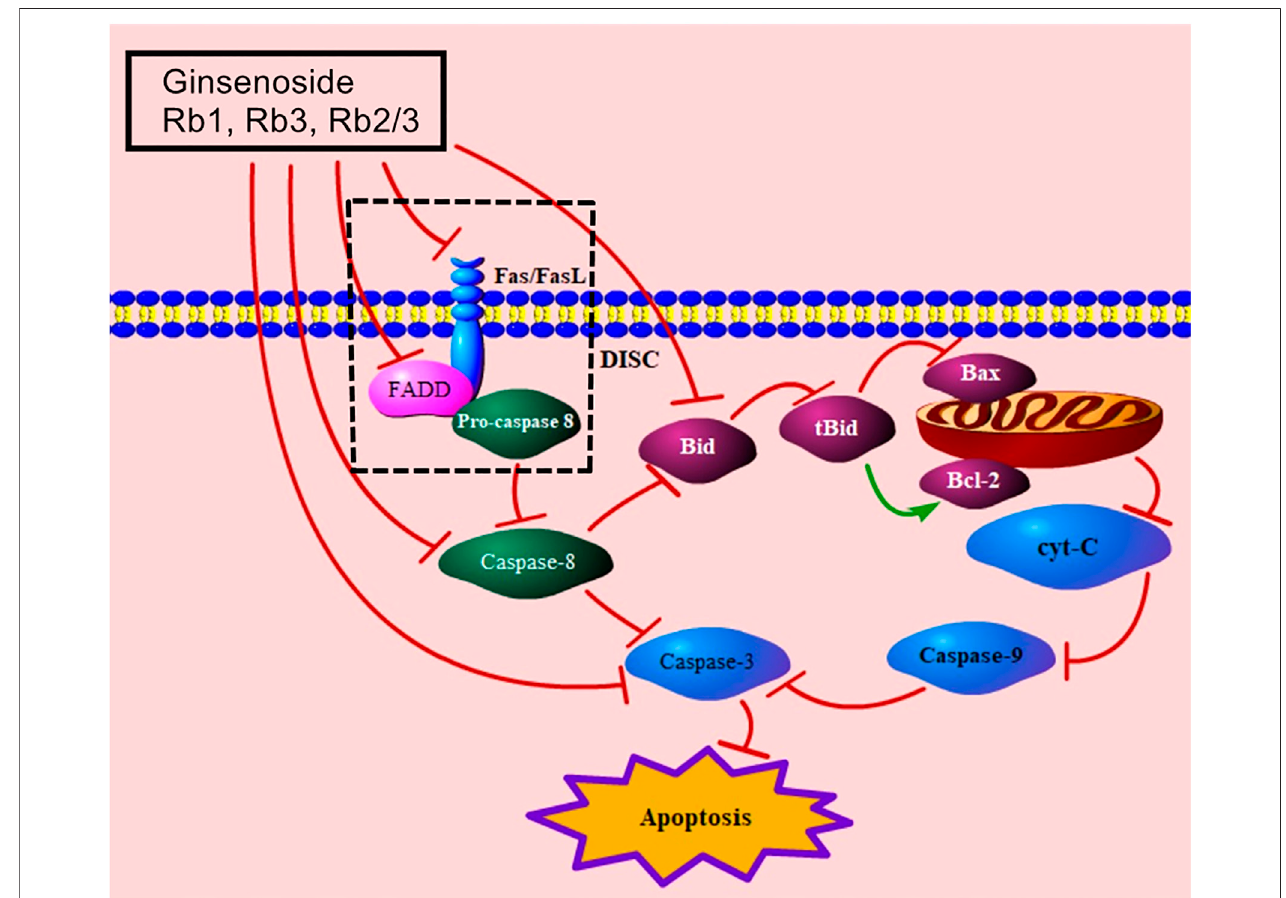
FIGURE 3 | Death receptor – mediated signaling pathway ofginsenoside in relieving MC apoptosis. FasL, Fas ligand; FADD, Fas-associated death domain protein; DISC, death-induced signal complex; tBid, truncated Bid; cyt-C, cytochrome C.